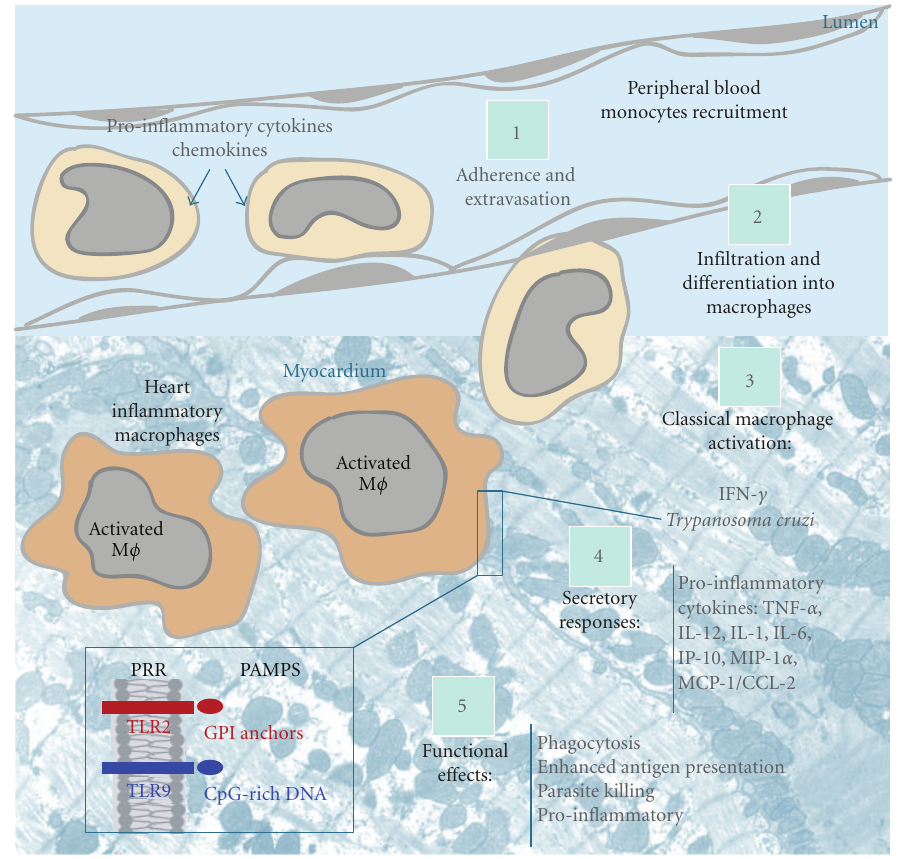
Figure 1: Activation of heart inflammatory macrophages during the acute infection with Trypanosoma cruzi . In response to acute infections, a cascade of events recruits cells derived from monocytic lineage from the peripheral blood into heart. This cascade culminates in a strong activation of macrophages. Classical activation of macrophages involves the key cytokine interferon gamma (IFN- γ ) and T. cruzi components (GPI anchors and CpG-rich DNA). These parasite products are recognized at the macrophage surface by Toll-like receptors (TLRs)-2 and 9, respectively. These receptors are a class of pattern recognition receptors (PRRs), which initiate an immune response and directly activates macrophages. Additionally, TLR-2 can heterodimerizate either TLR1 or TLR6 to recognize T. cruzi GPI anchors [33]. TNF- α is one of the most e ffi cient activators of macrophages to a trypanocidal function. PAMPS, pathogen-associated molecular patterns; GPI, glycosyl phosphatidy linositol; TNF- α , tumor necrosis factor-alpha; MIP-1 α , macrophage inflammatory protein α ; MCP-1/CCL-2, monocyte chemoattractant protein-1; IP-10, inducible protein